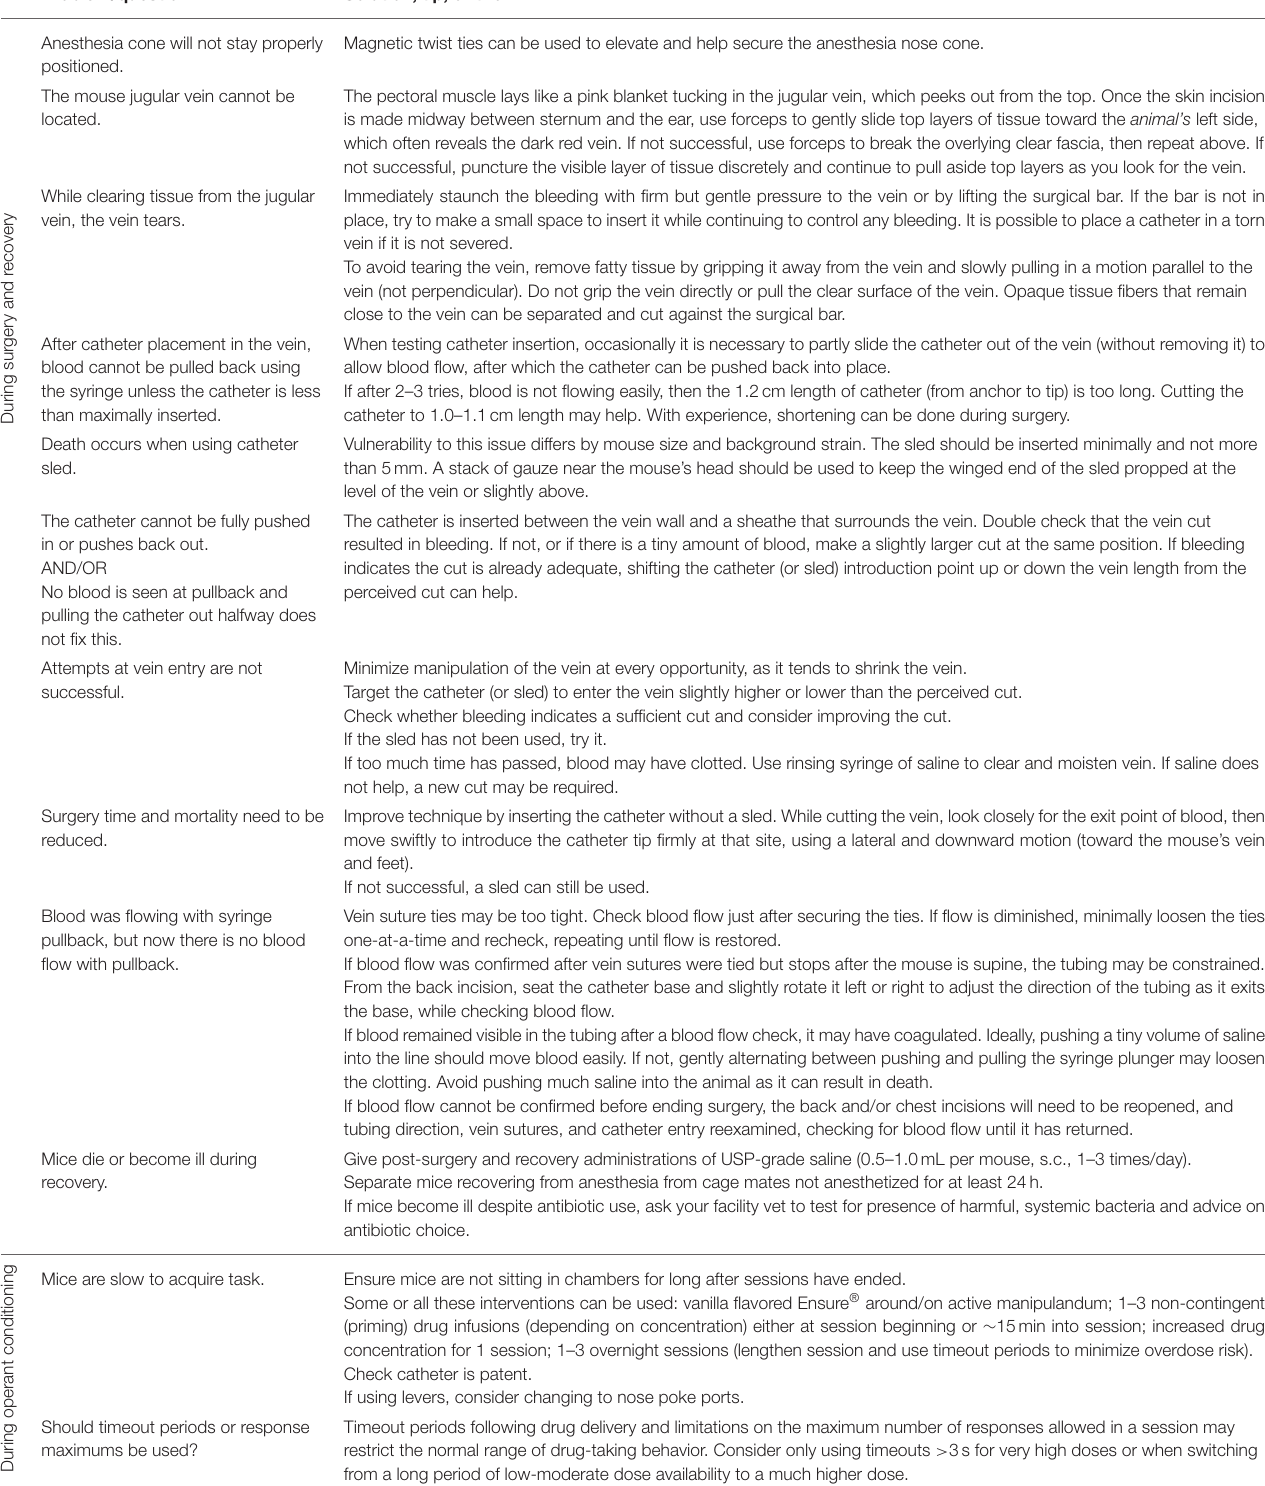
TABLE 4 | Troubleshooting, tips, and tricks. Problem/question Solution, tip, or